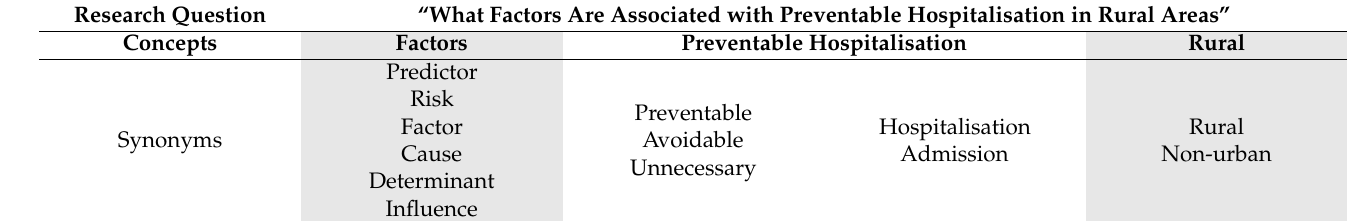
Table A1. Database-specific search